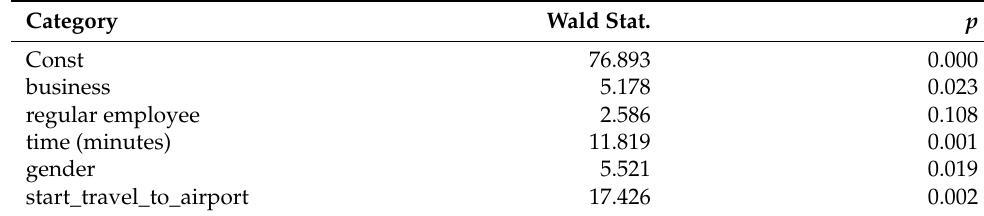
Table 6. General results for ordered logit from Table